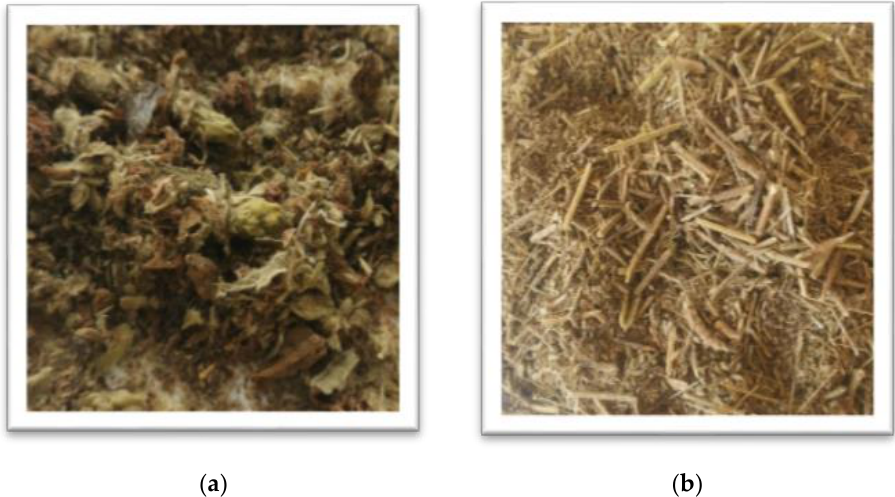
Figure 1. Hexane extracted rose flowers ( a ) and steam distilled lavender straw ( b